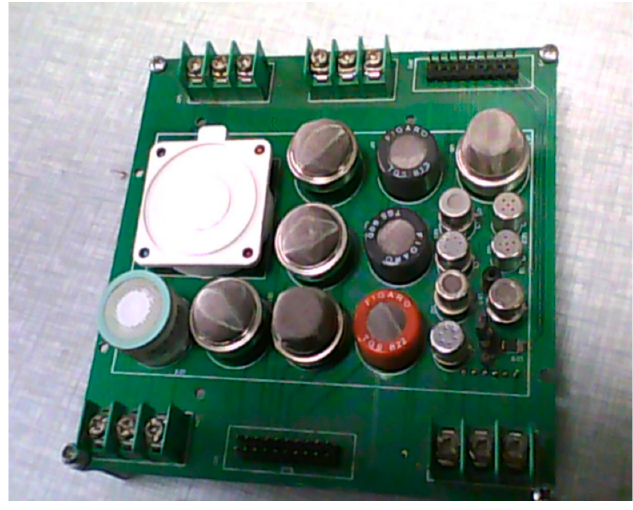
Figure 1. Electronic nose sensor array.